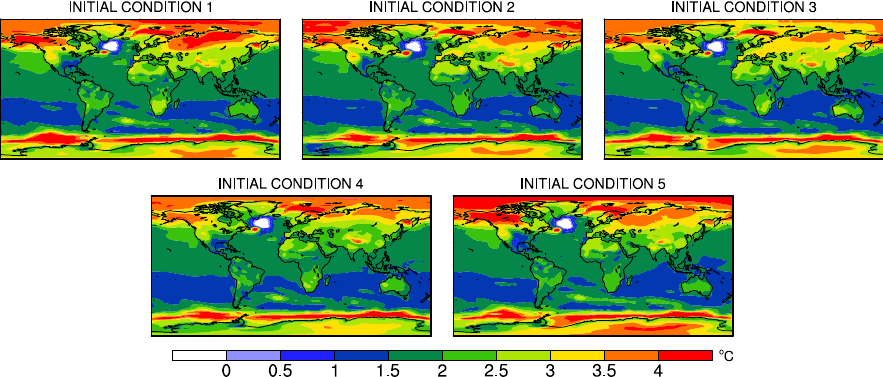
Fig. 16. Changes in annual mean surface air temperature ( ◦ C) for the period 2081–2100 relative to 1981–2000 for the five simulations with different initial conditions under the median climate sensitivity and L2S